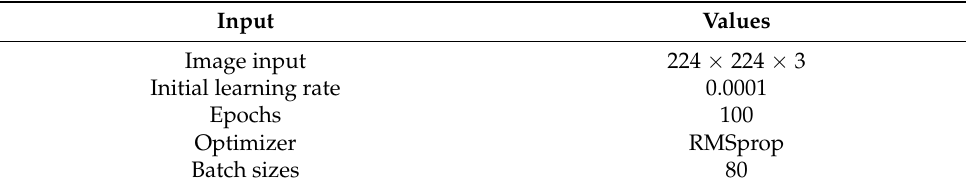
Table 1. Parameters of the MobileNet